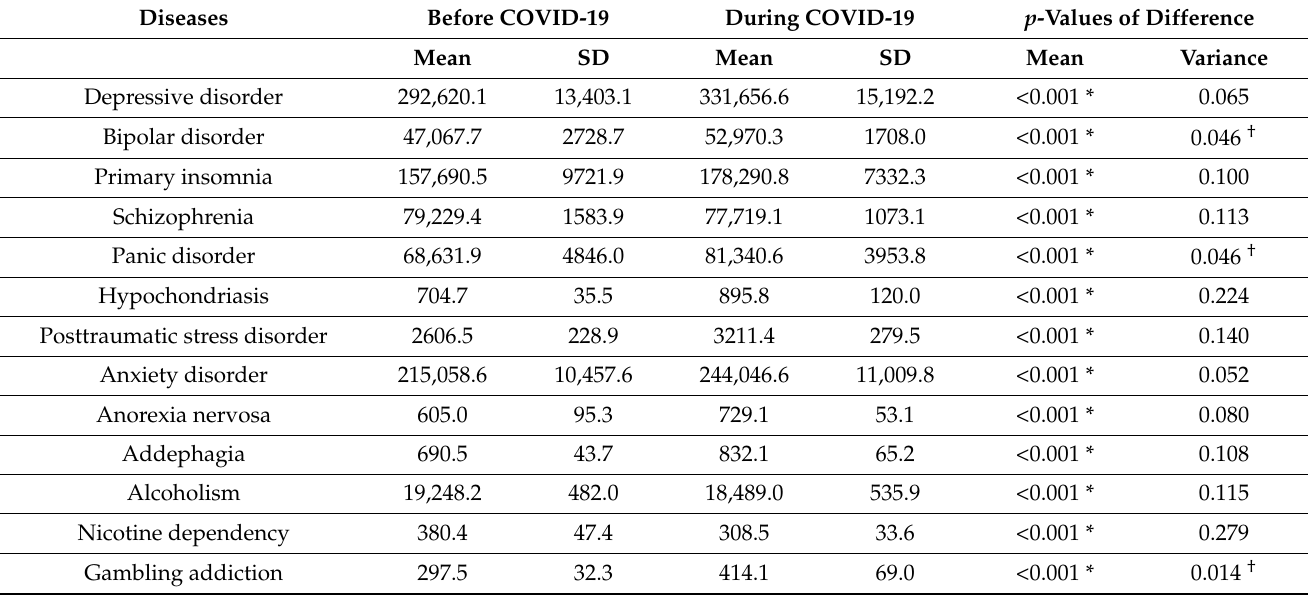
Table 1. Mean, standard deviation of incidence of diseases before and during COVID-19, and their